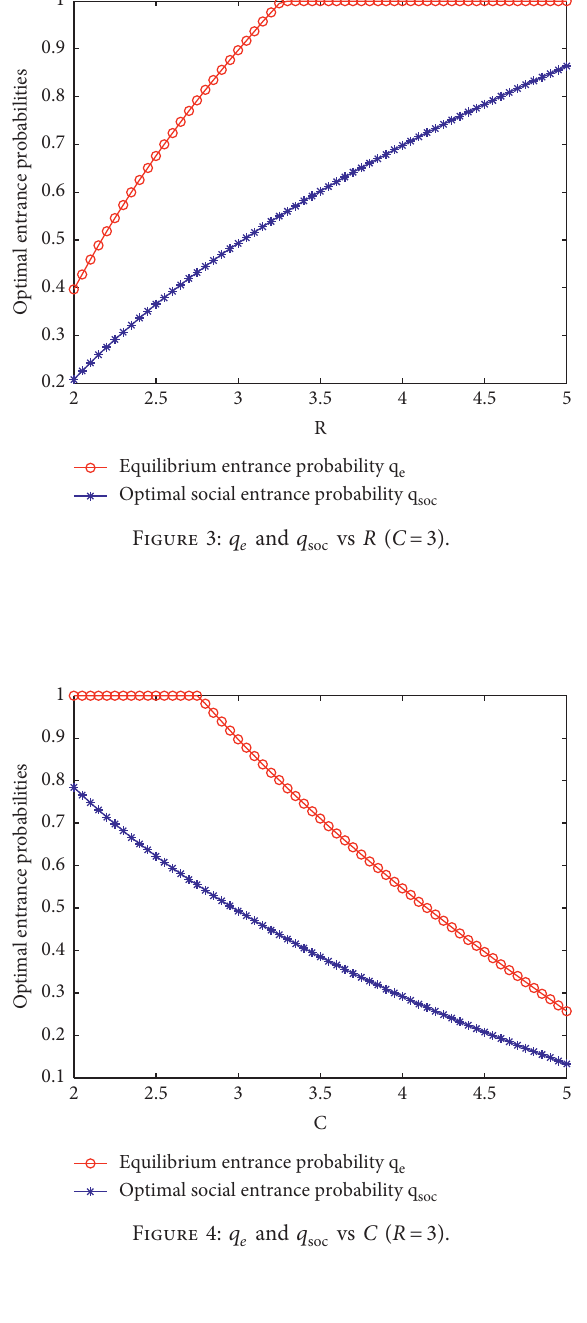
q vs C ( R � 3). e and soc